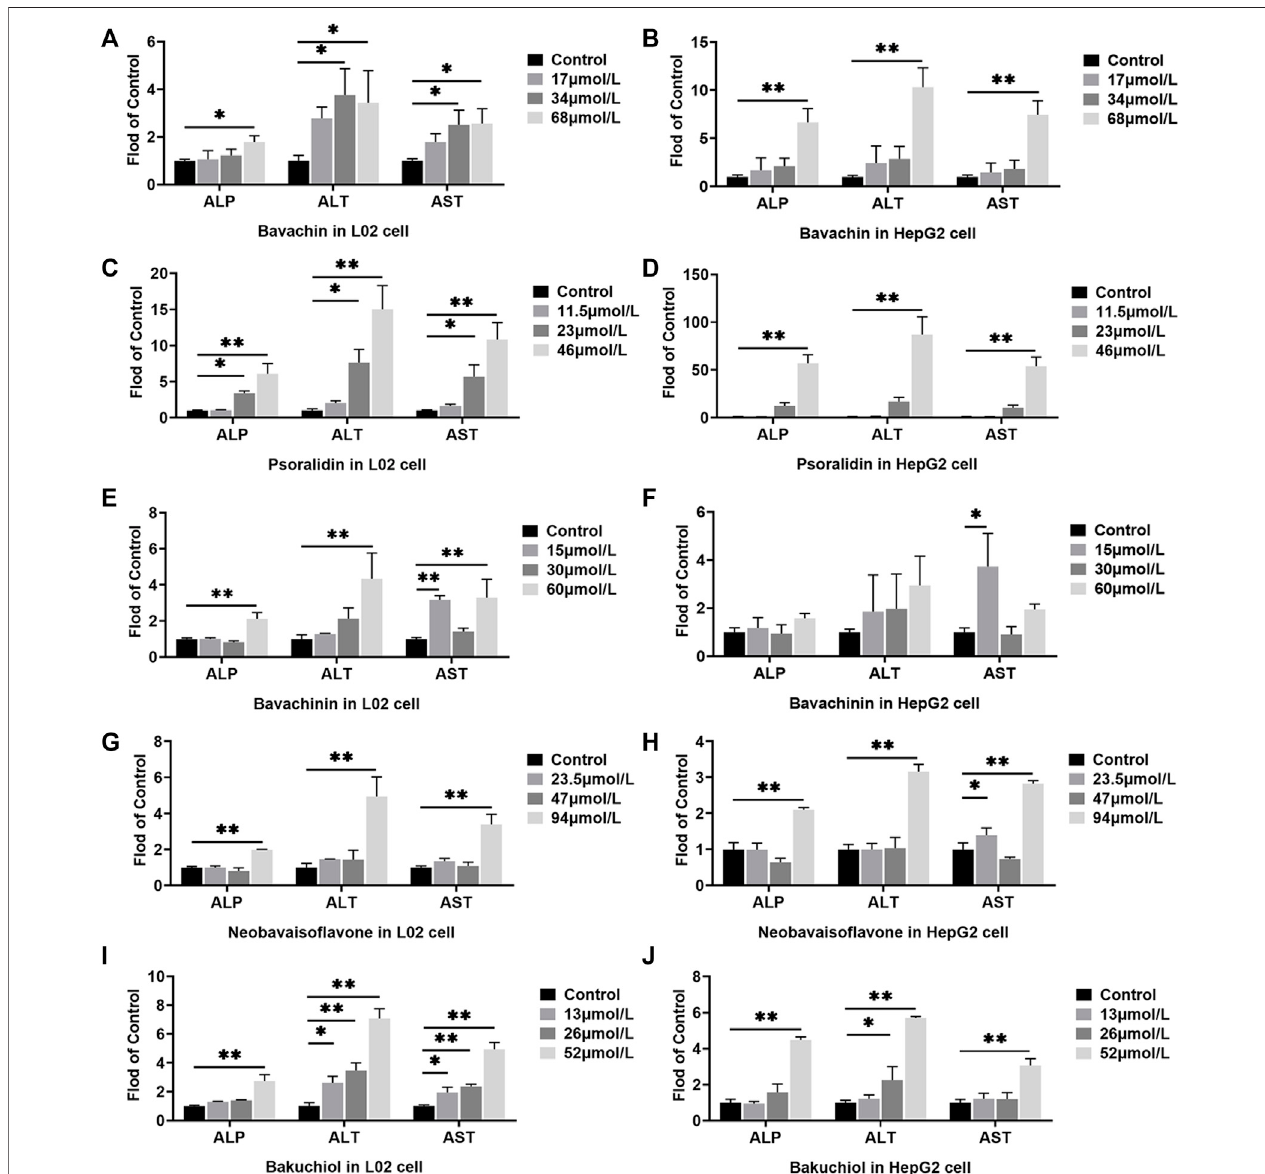
FIGURE6| Effectsofdifferentdosesofbavachin (A,B) ,psoralidin (C,D) ,bavachinin (E,F) ,neobavaiso fl avone (G,H) ,andbakuchiol (I,J) ontheALP,ALT,andAST levelsinL02andHepG2cells.Thevaluesarepresentedasmean ± SDand n (cid:1) 6.* p < 0.05,** p < 0.01versusthecontrolgroup.ALP,alkalinephosphatase;ALT,alanine aminotransferase; AST, aspartate